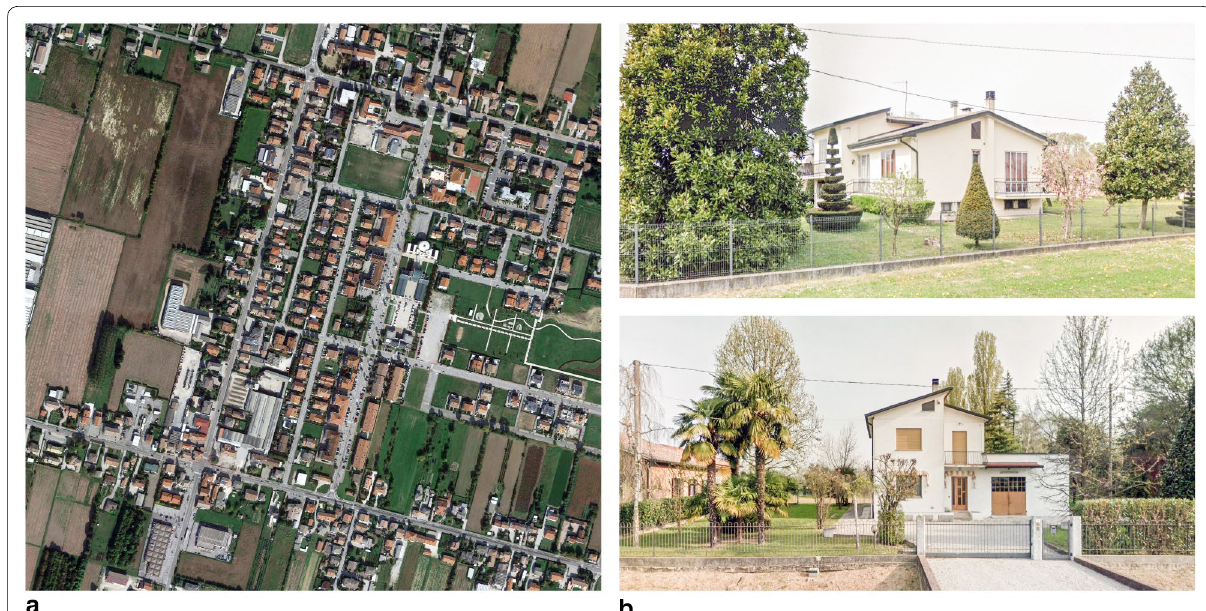
Fig. 7 a Municipality of Borgoricco, 1 1 km sample. Linear settlements of family houses (Google Earth). b Municipality of Arsego and × Campodarsego, family houses (Google Street